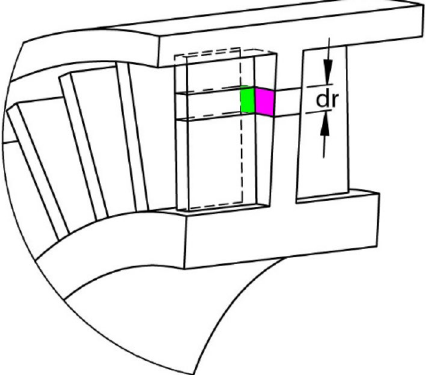
Figure 7. Two areas with and without connection to a fin.